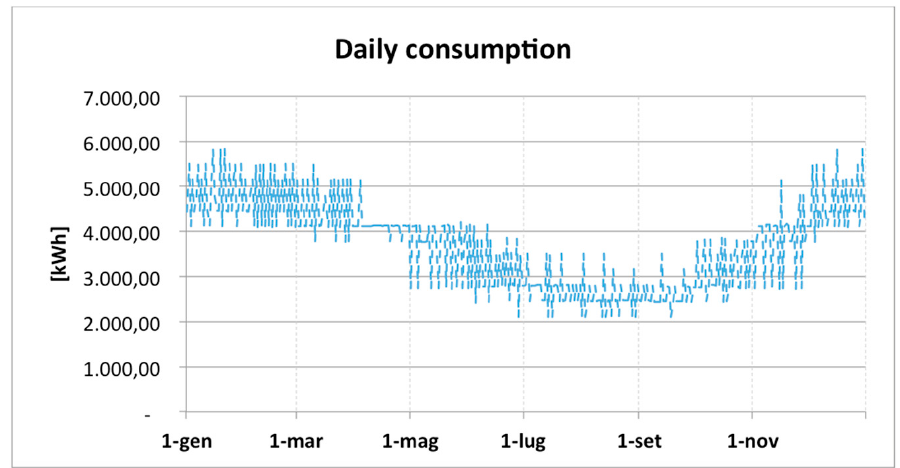
Figure 10. Daily energy consumption for the system.